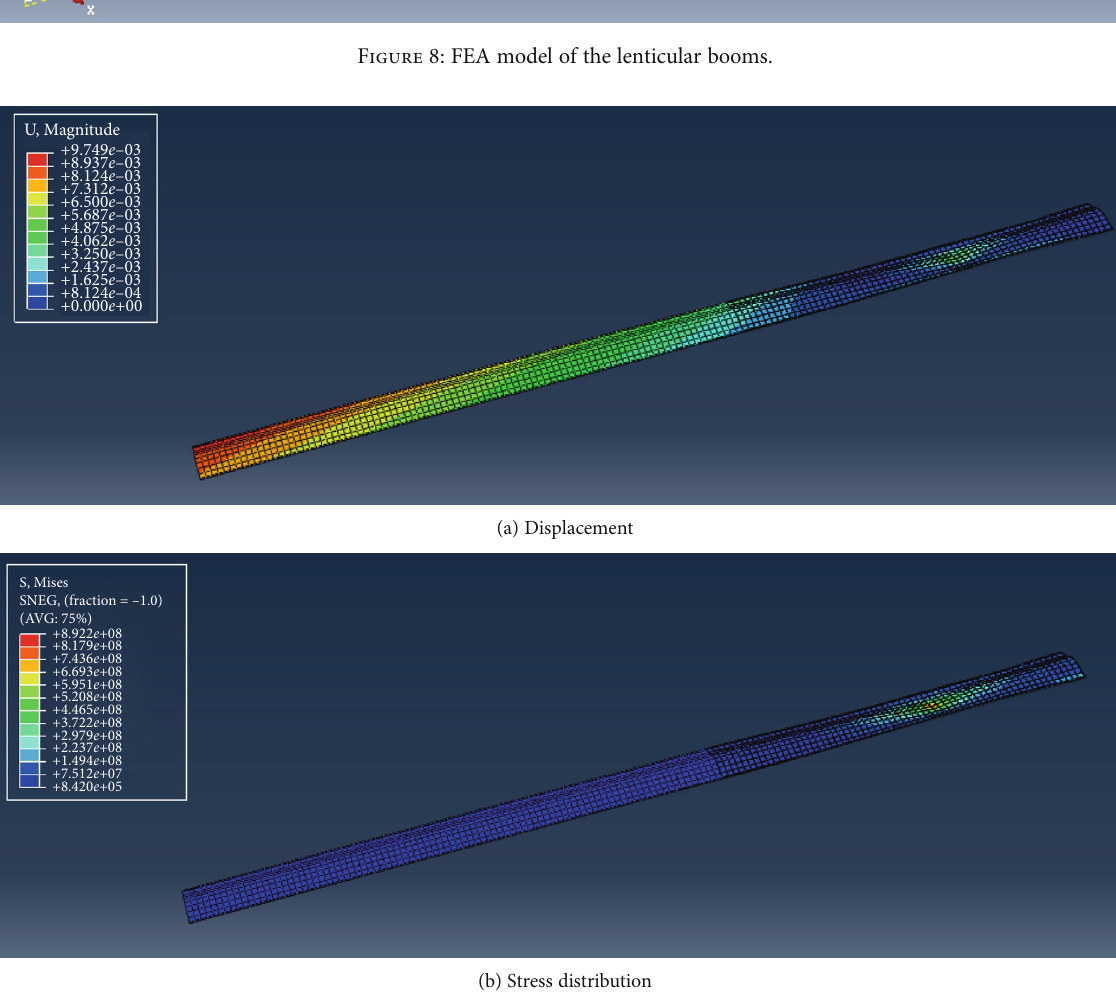
Figure 9: Con fi guration after the press fl attening